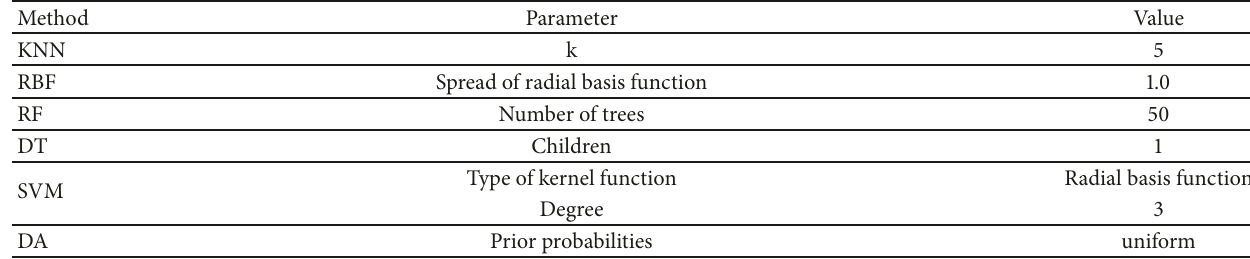
Table 9: Initialization parameters of other classification methods.